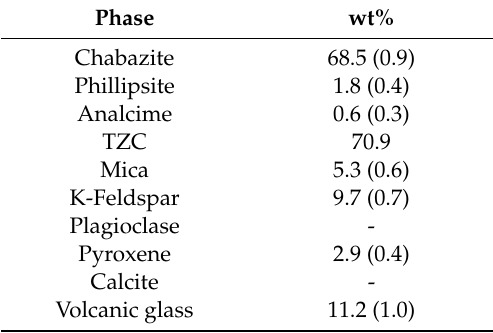
Table 1. Quantitative phase analysis of the employed chabazite-rich zeolite at natural state (Natural-ZT) quarried in the Sorano area. Data from [40]. Standard deviation within brackets. TZC refers to total zeolitic